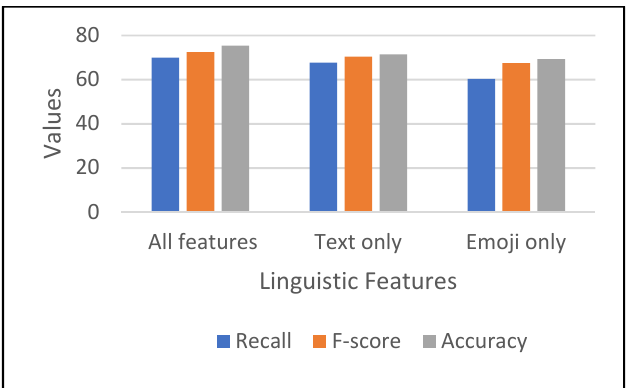
Figure 4. Different linguistic features relative performance for SVM classifier.